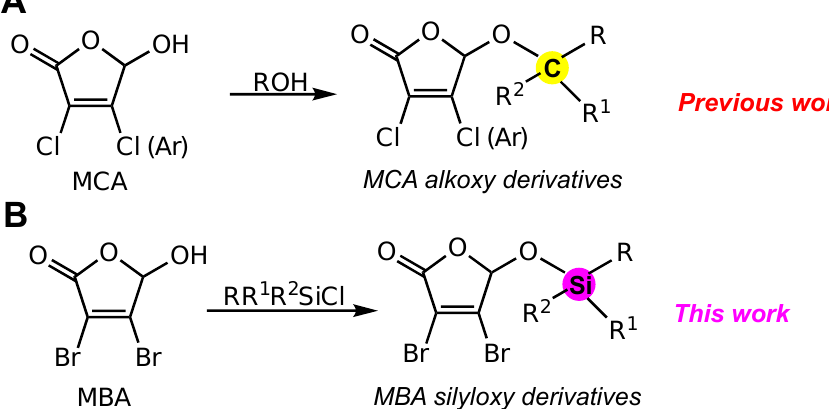
Figure 1. Strategy of compound design. ( A ) synthesis of alkoxy derivatives of MCA, ( B ) synthesis of silyloxy derivatives of MBA